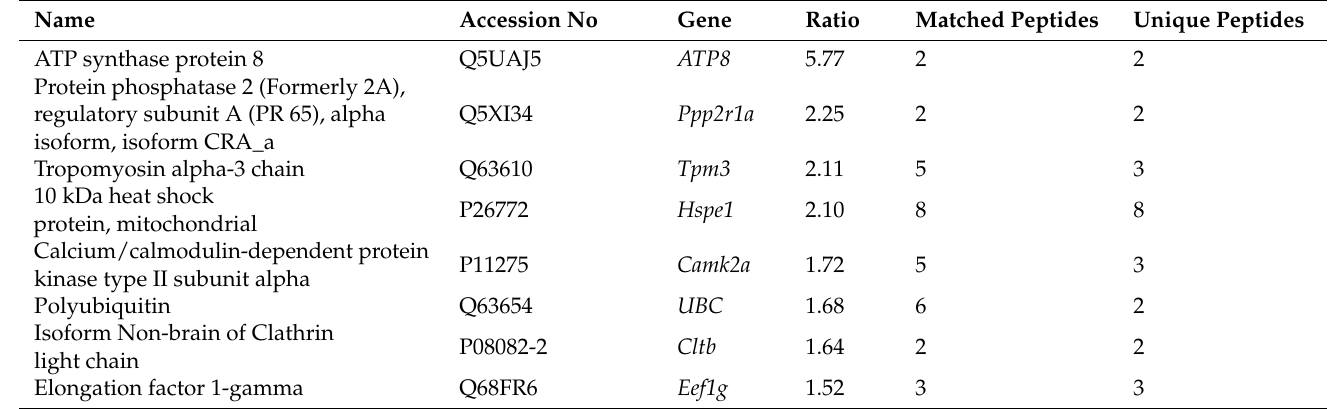
Table 2. Synaptosomal differentially upregulated expressed proteins in chronic social isolation (CSIS) vs.